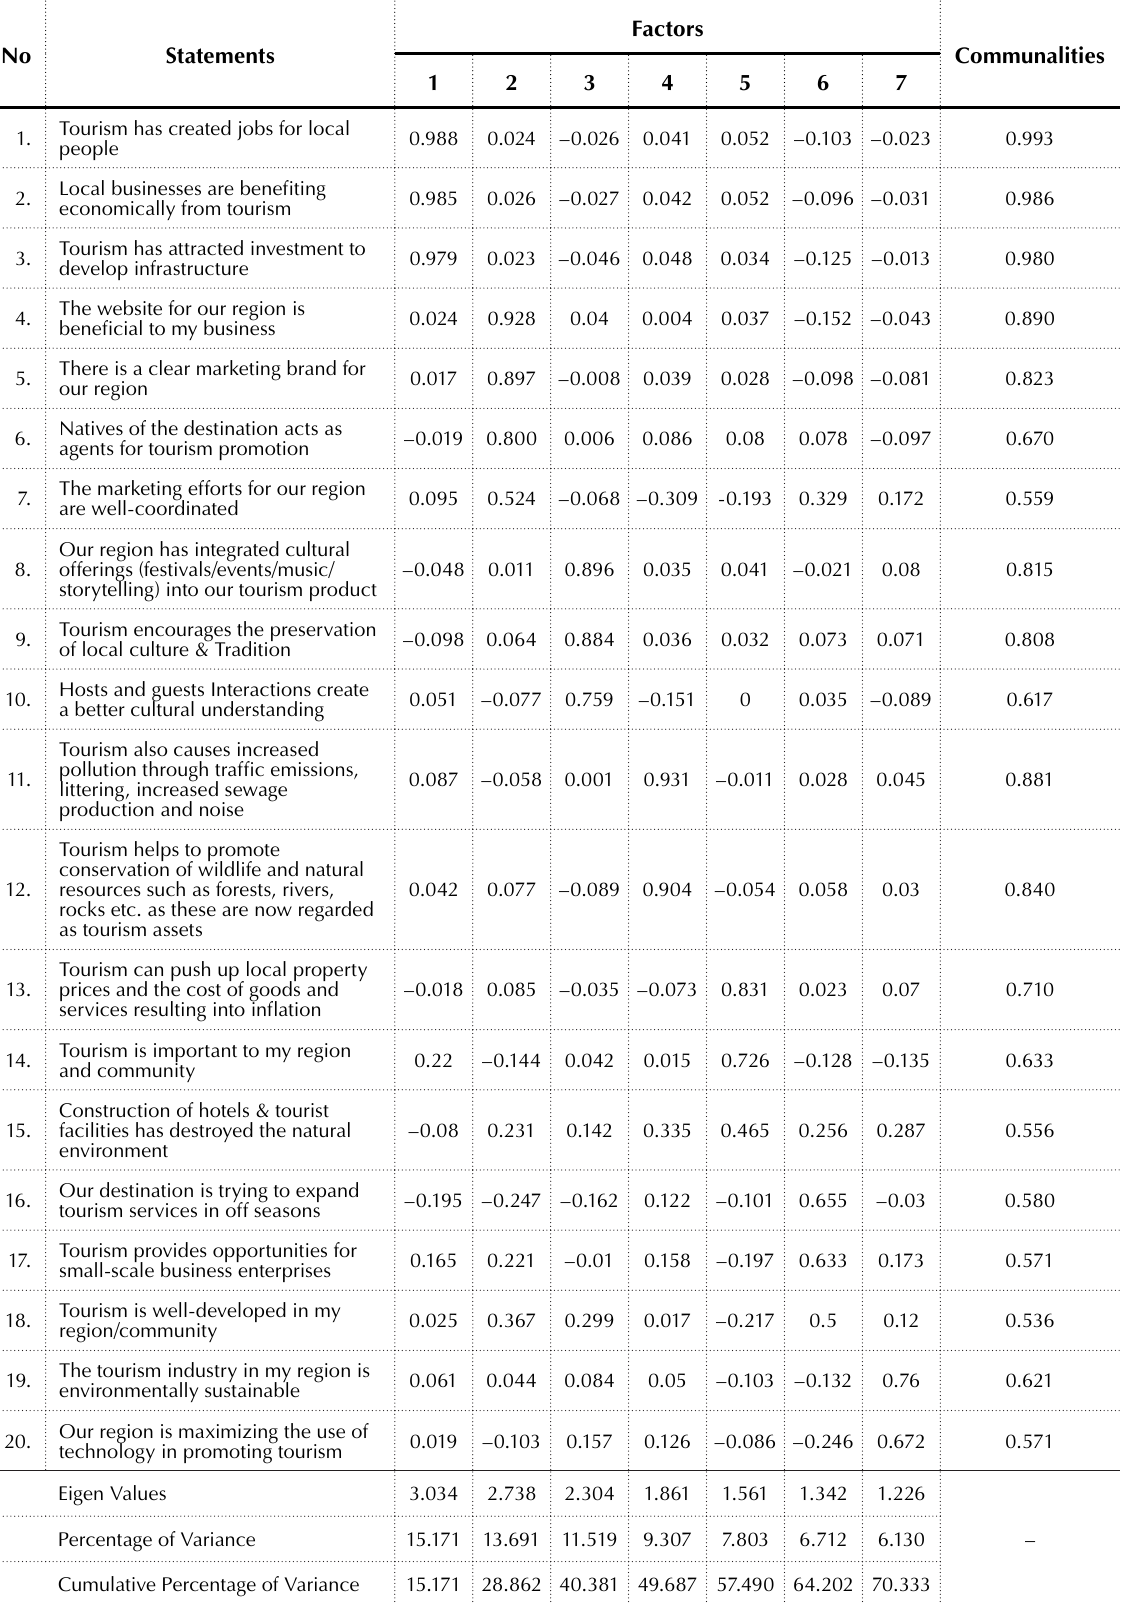
Table 4. Principal Component Analysis with Varimax Rotation for the statements related to impact of tourists on destination attributes in Himachal